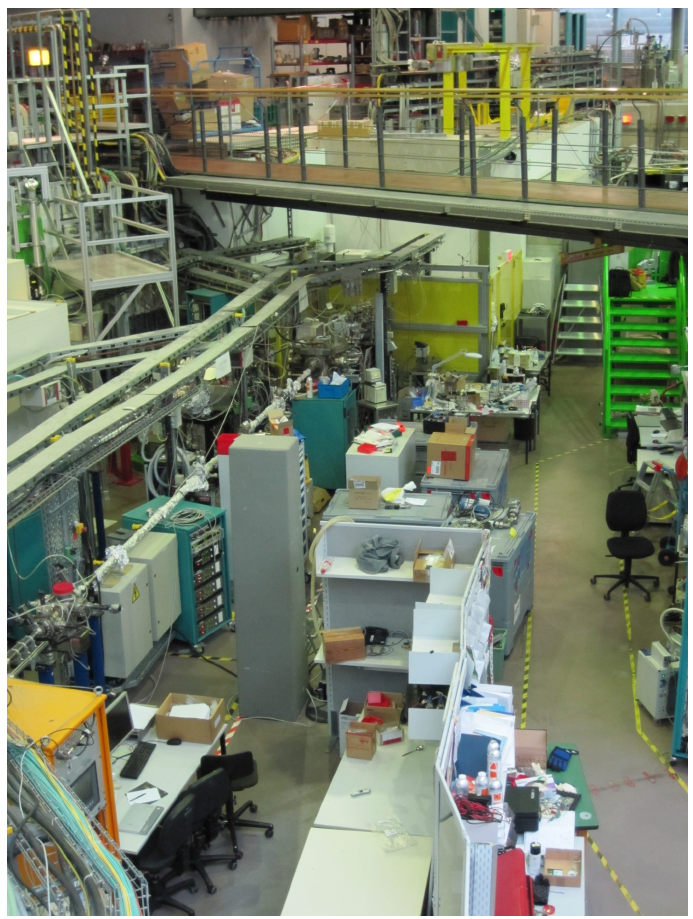
Figure 1: Top-view of beamline UE52 SGM.